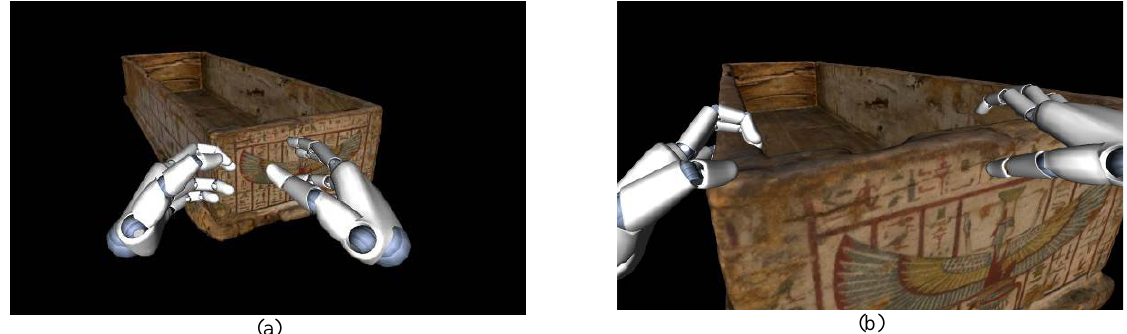
Figure 8. Some pictures of the implemented VR scenario: (a) (b) the grabbing and rotating of the object with the possibility of enlarging